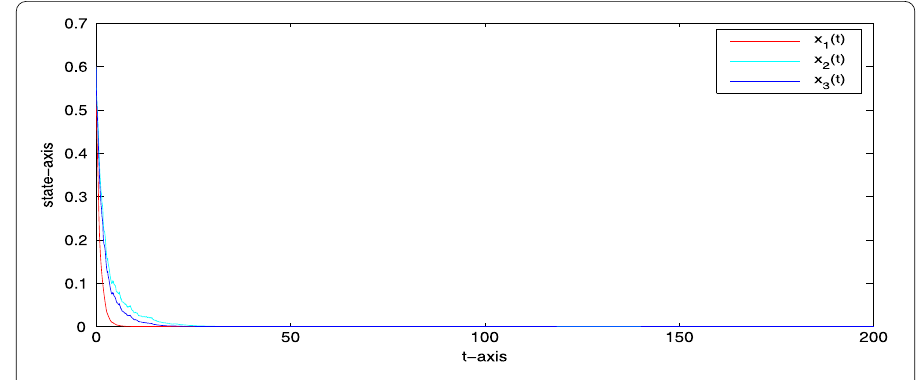
Figure 8 All species go to extinction with γ 1 ( u ) = 2.5, γ 2 ( u ) = 2, γ 3 = 3.5, and the other parameters are the same as those for Fig.